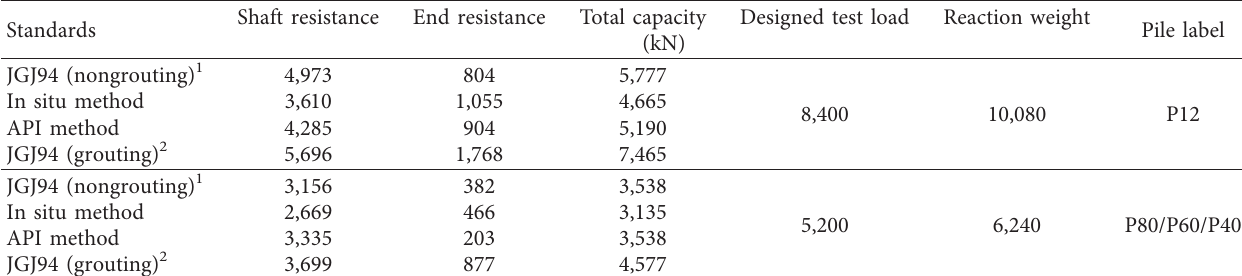
Table 2: Ultimate bearing capacity of